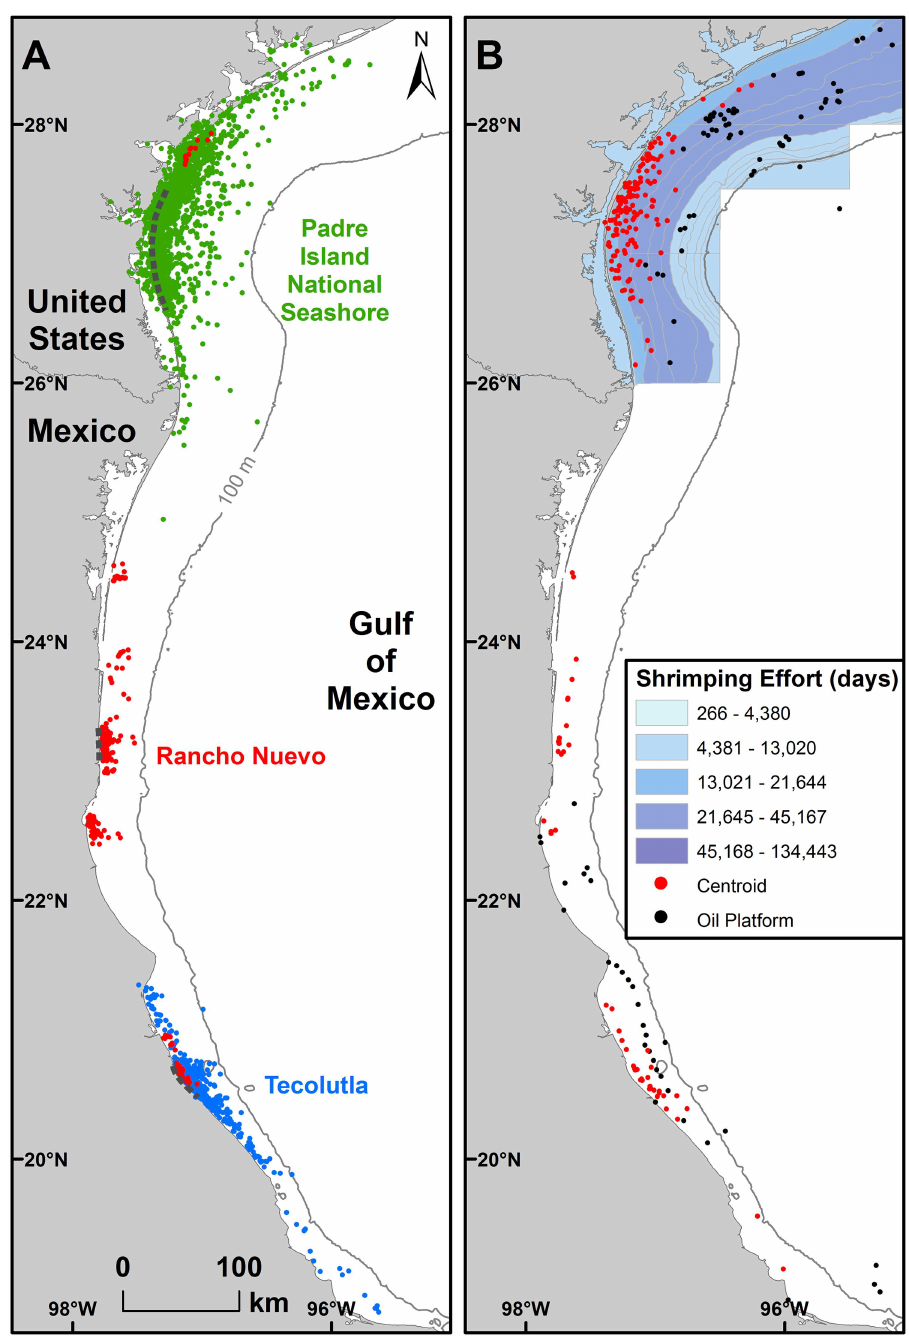
Fig 2. Inter-nesting habitat for Kemp’s ridley turtles trackedafter nesting. Includesn = 60 tracked after nestingat Padre Island NationalSeashore, Texas, USA during1998 through 2013, n = 11 at Rancho Nuevo, Tamaulipas, Mexico during2010 and 2011, and n = 11 at Tecolutla, Veracruz, Mexico during2012 and 2013. (A) Mean daily locationsfor turtles tracked duringinter-nestingperiods (n = 82) (B) Kernel density estimates (KDE) centroids and minimumconvex polygon(MCP) centroids(red dots) (n = 92) in relationto active oil and natural gas platforms (black dots) in the USA (through2014; data from http://www.data.boem.gov) and Mexico (through2012; data from https://www.fas.org/sgp/crs/row/R43313.pdf)and shrimp trawling effort in the USA (days; data providedby NOAA) from May through August of 2010–2013;data were not availablefor